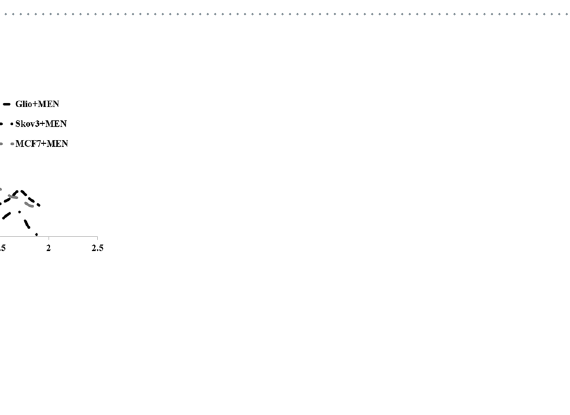
Figure 4. CW-NMR spectra including cells only, cells incubated with MENs for ( a ) glioblastoma cells U87-MG, ( b ) ovarian carcinoma cells Skov3, ( c ) breast adenocarcinoma cells MCF-7, respectively, and ( d ) normal brain endothelial cells.